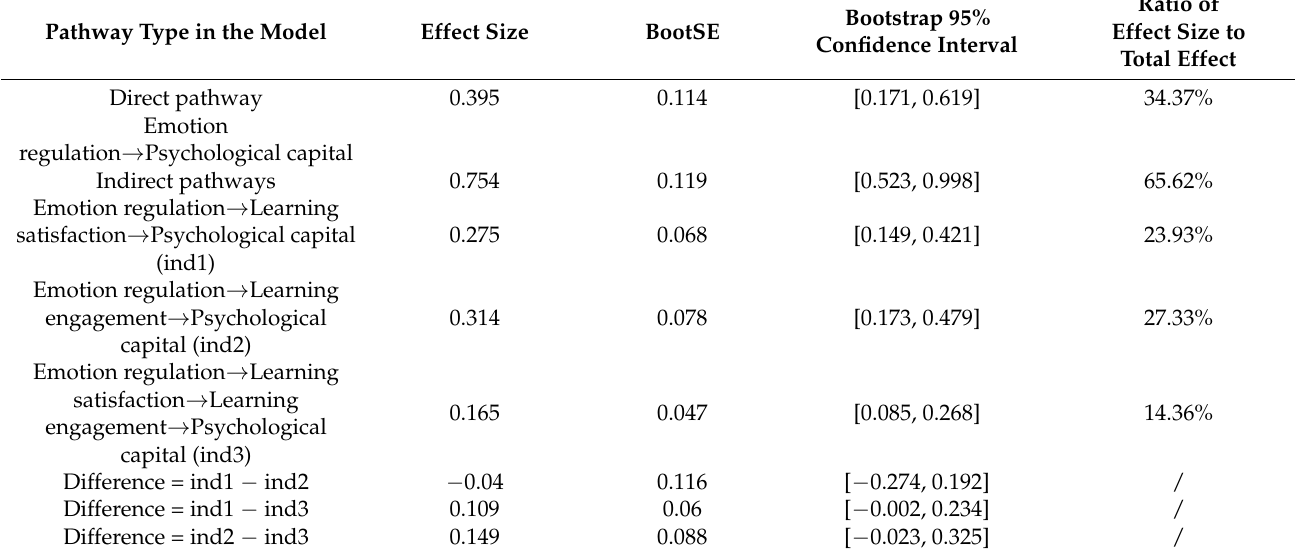
Table 6. Test results of the mediation